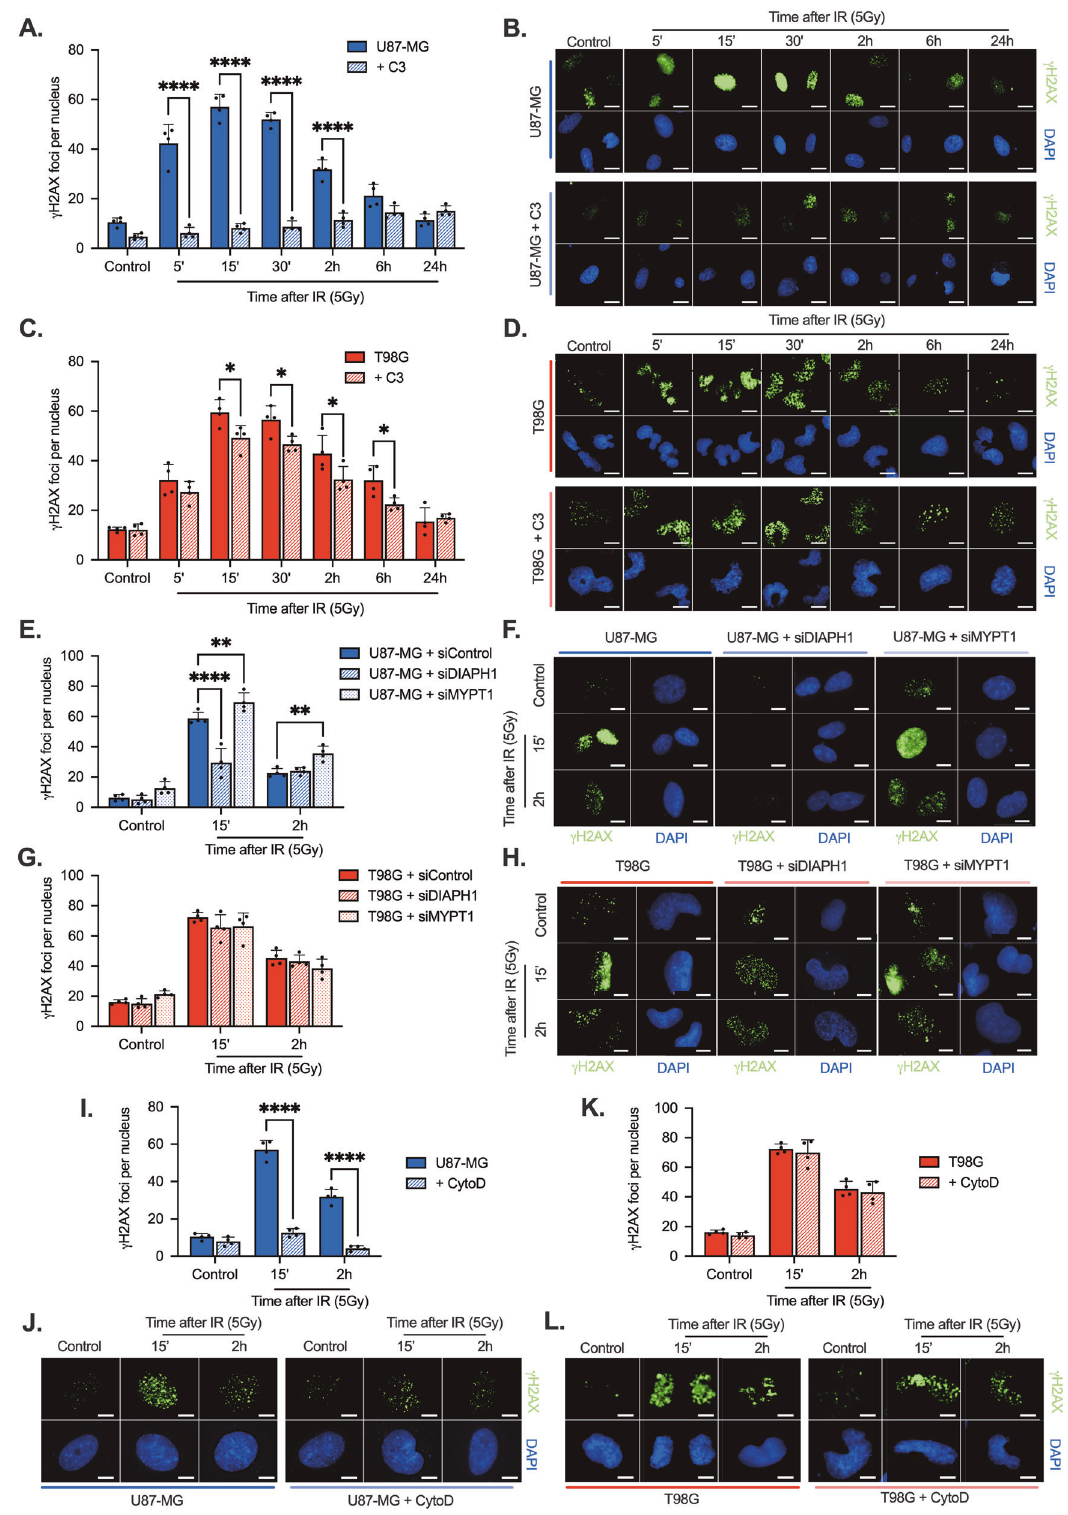
recruitment to DNA damage sites is Rho-dependent only in p53- wild-type cells. DSB repair activity through the HR pathway was quanti fi ed by transfecting cells with an inactive GFP reporter gene, which is repaired by the HR machinery using a 3' inactive fragment of GFP (iGFP) located downstream of the reporter gene, Cell Death and Disease (2023)